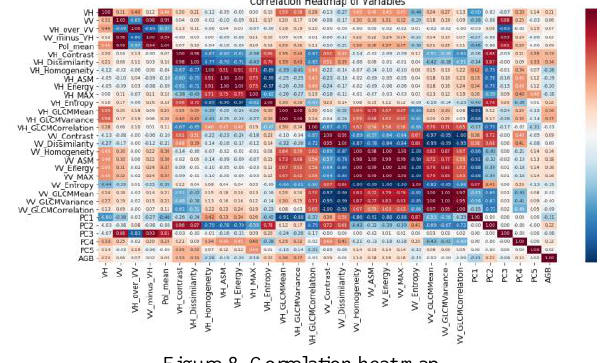
Figure 8. Correlation heat map